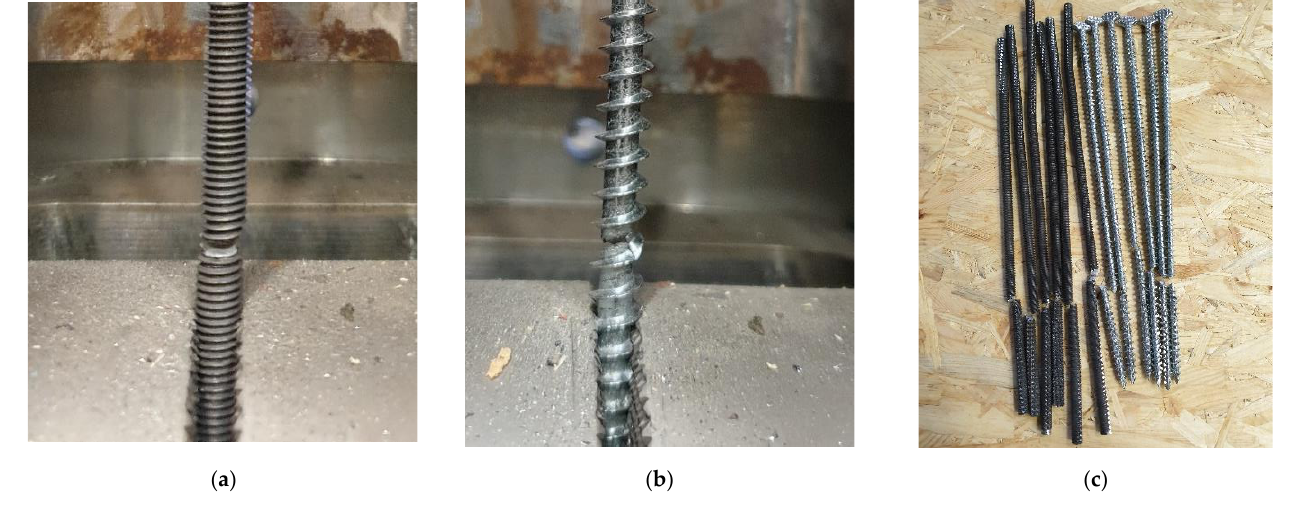
Table 3. Evaluation of the tension test of fasteners.